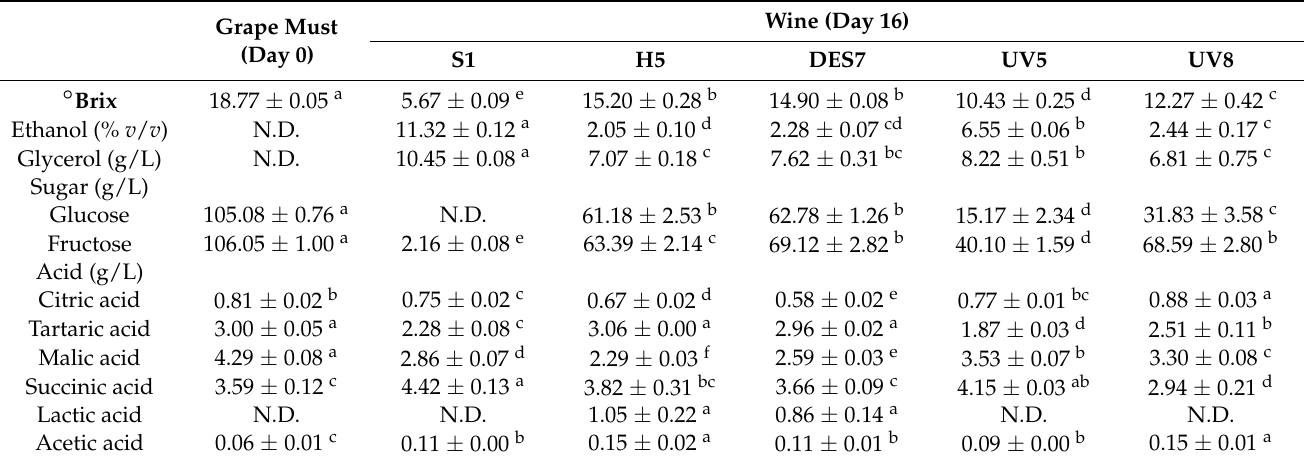
Table 3. The physicochemical indexes in the grape must and